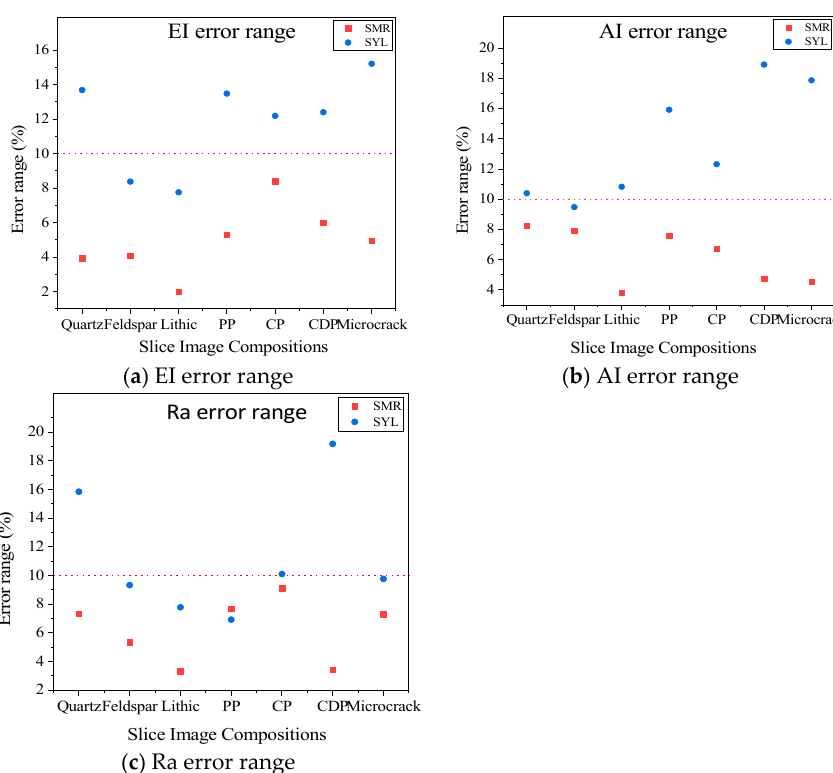
Figure 6. EI, AI and Ra calculation results of each component profile of tight sandstone thin section images.